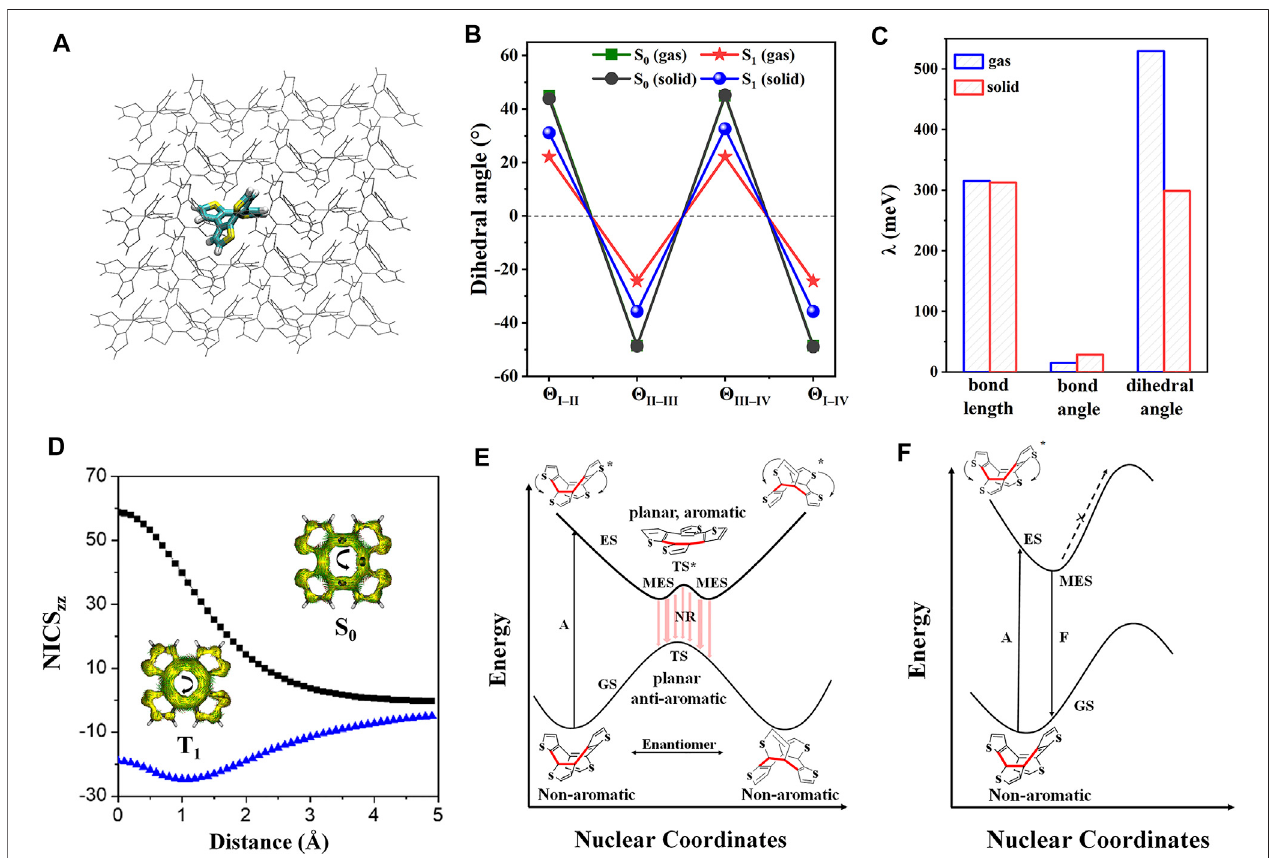
FIGURE 3 | (A) QM/MM model of COTh in the crystalline state. (B) Key dihedral angles in both dilute solution and crystal at S 0 and S 1 states. (C) Projection λ of COTh on internal coordinates, including bond lengths, bond angles, and dihedral angles. (D) NICS zz scan of COTh based on its transition-state structures at the S 0 (black) and T 1 (blue) states. The ACID plots ofboth S 0 and T 1 states were inthe inset. Proposed decay pathwaysalong thepotentialenergy surface ofCOTh (E) in dilute solution and (F) in solid state. Abbreviation: GS, ground state; ES, excited state; TS, transition state; MES, minimum energy structure; A, absorption; F, fl uorescence; NR, non-radiative decay. (Reproduced with permission from (Zhao Z. et al., 2019); This fi gure is extracted from an open access journal with thanks; Copyright 2019 Nature Publishing